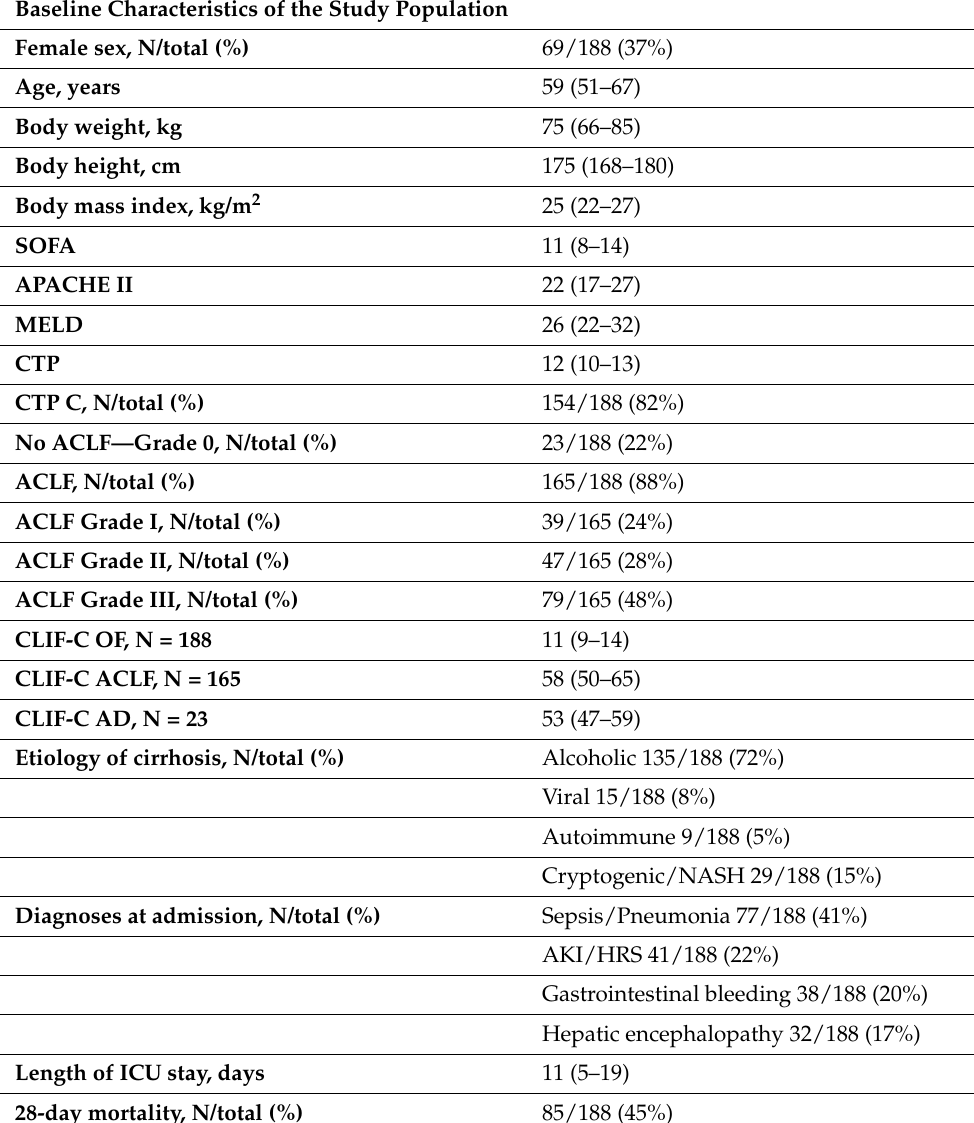
Table 1. Baseline characteristics of the study